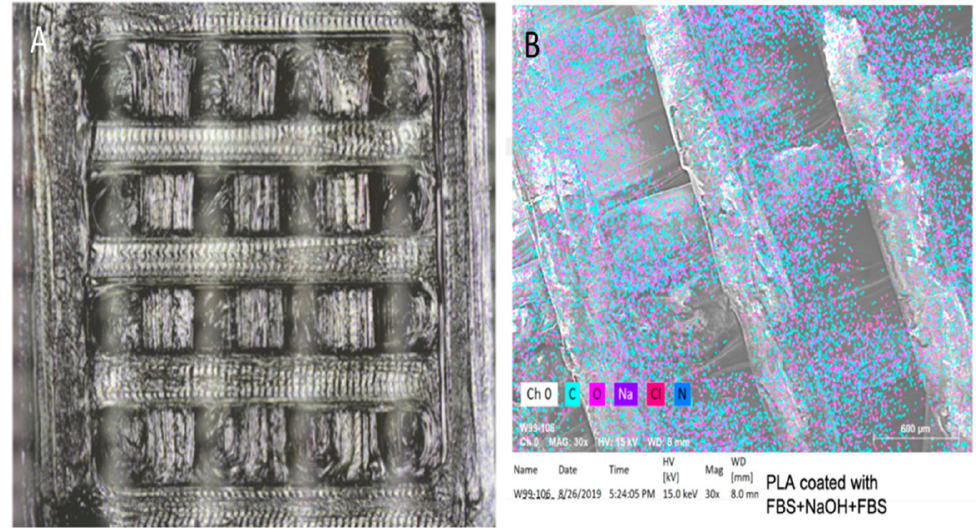
Figure 7. ( A ) Optical and laser combined image of 3D printed PLA square. ( B ) EDS elemental analysis for coated PLA square [87].